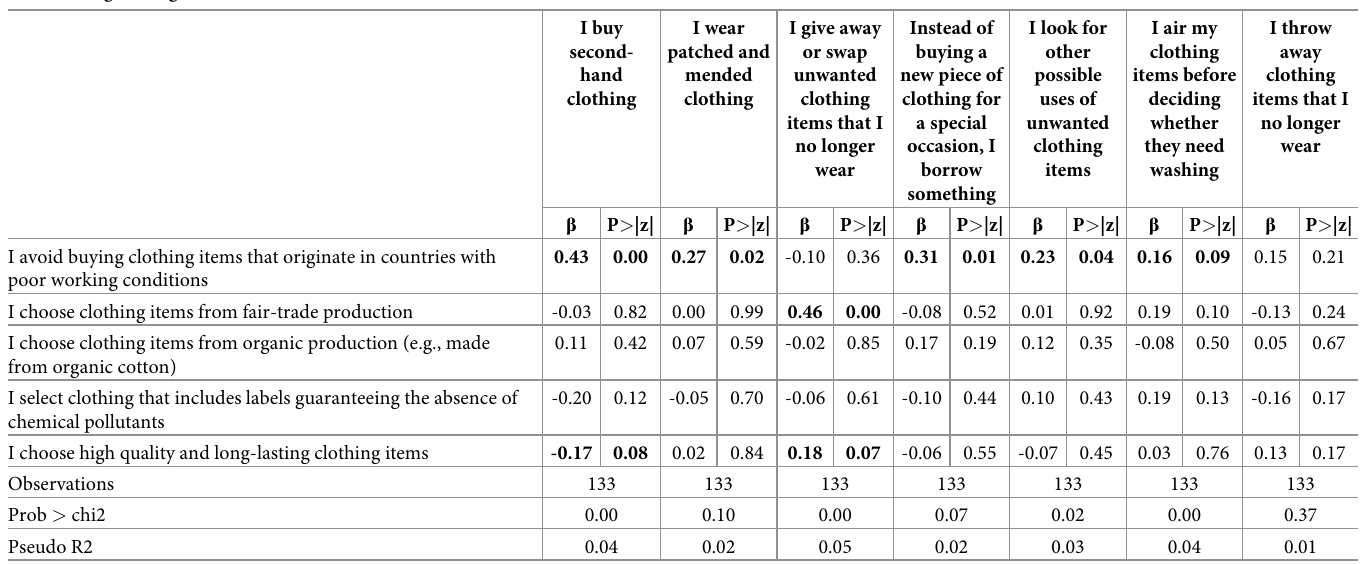
Table 3. Logistic regression of